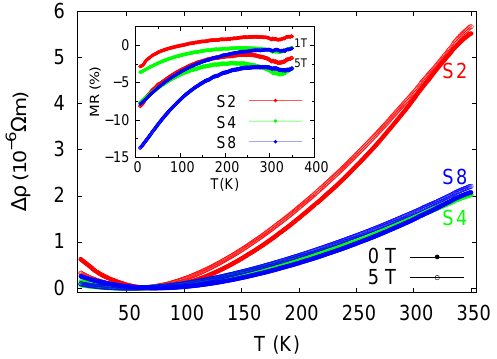
Fig. 4. Magnetic field dependence of magnetoresistance for all the samples at 350 K and 10 K. The inset shows the detail of the curves at 10 K and in low magnetic fields. The curves in the inset are shifted from each other in order to see the di ff erent shape of the curves in low magnetic field